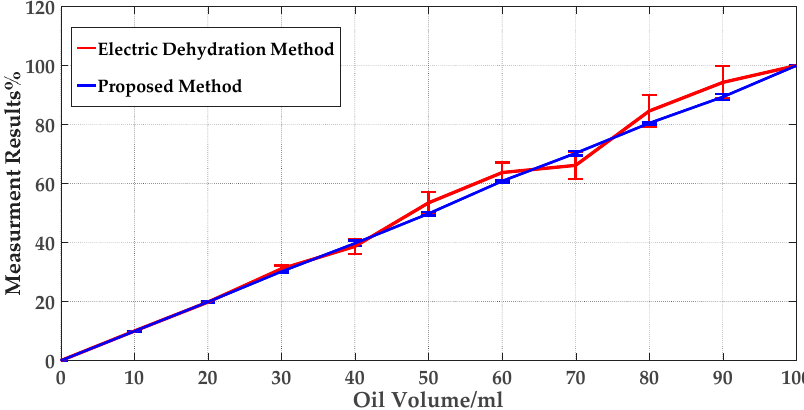
Figure 10. Comparisons about the proposed method and traditional method.